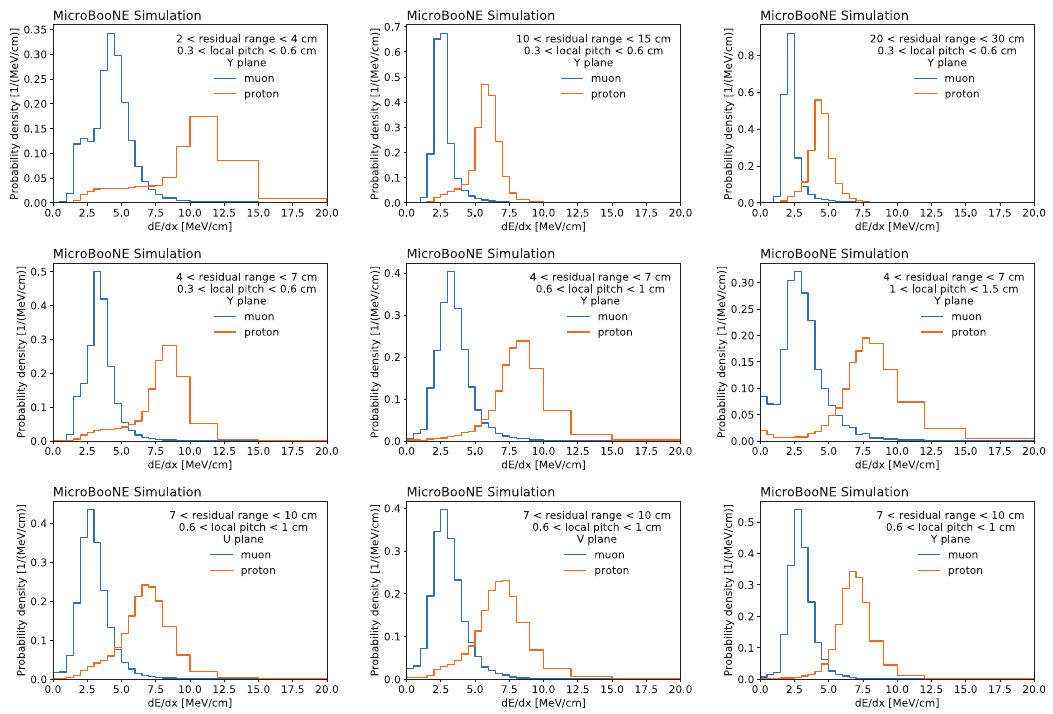
Figure 4. Expected d E/ d x distributions for muon (blue) and proton (orange) hits. The top row shows distributions on the collection plane, with a fixed value of local pitch, and three different values of the residual range. The middle row shows distributions on the collection plane, with a fixed value of the residual range, and three different values of local pitch. The bottom row shows distributions on the three wire planes, with a fixed value of residual range and local pitch. As expected, the peak d E/ d x value reduces at higher residual range, passing from 11 MeV/cm